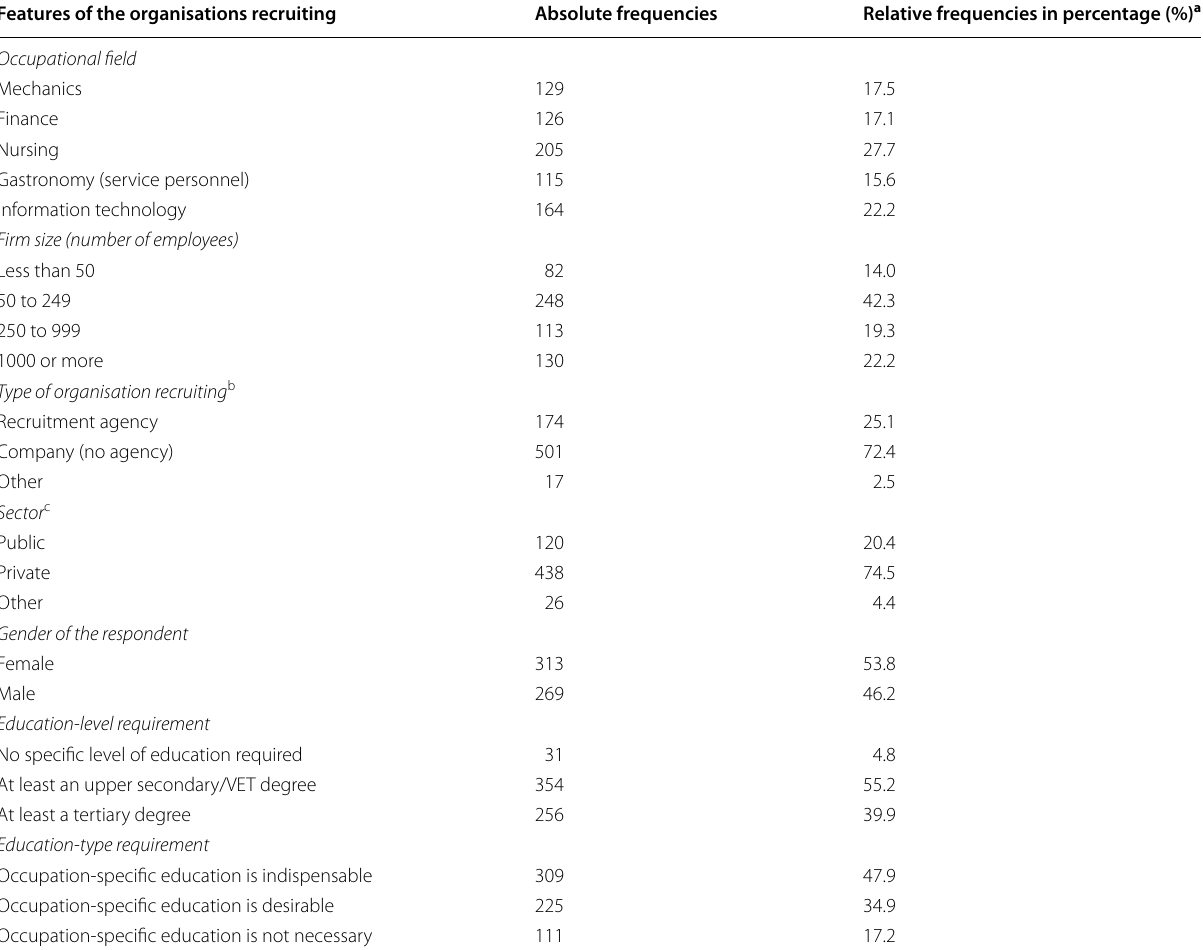
Table 1 Frequencies of features of the organisations recruiting (data gathered from the recruiter